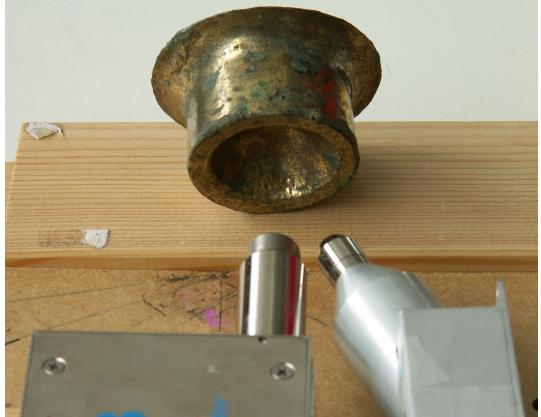
Figure 5. Picture of the experimental setup geometry: Uncollimated detector (on the left) placed vertically with respect to the surface of the sample and X-ray tube usually forming an angle between 30 ◦ and 45 ◦